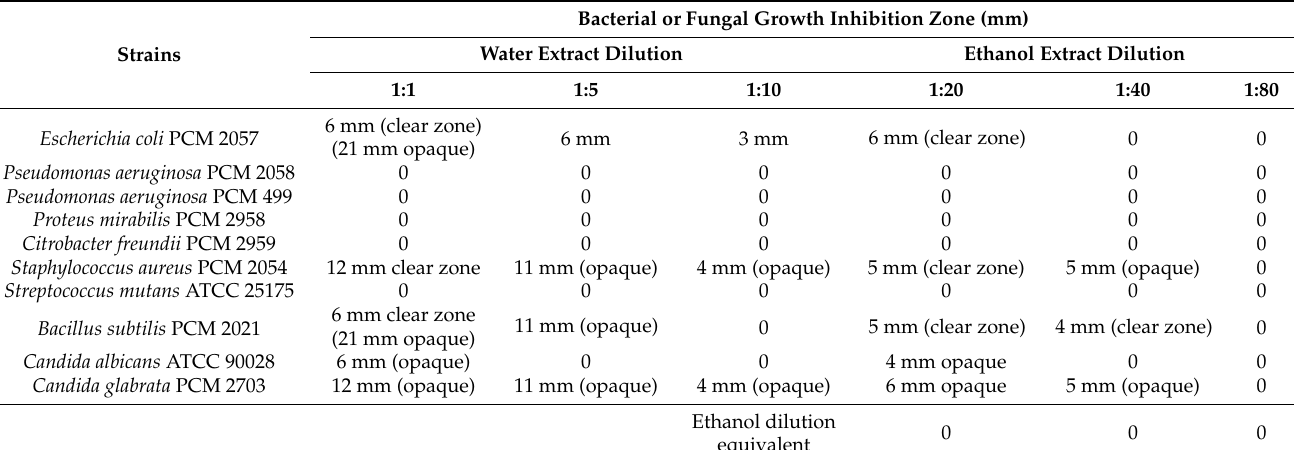
Table 4. Antibacterial and antifungal effects of water and ethanol extracts of Alder acorns. Bacterial or Fungal Growth Inhibition Zone